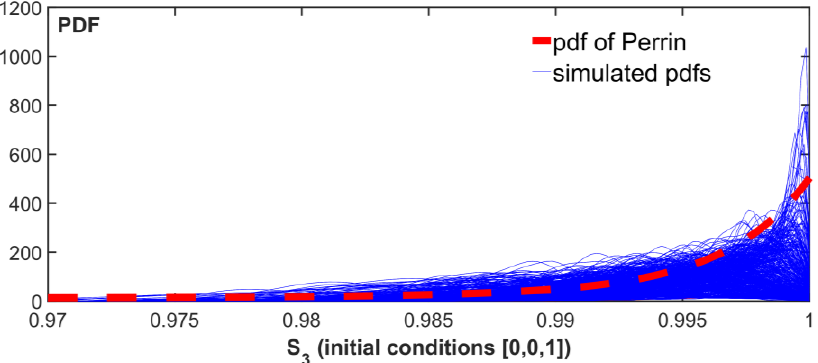
Figure 10. Perrin’s pdf and simulated pdfs for a circular SOP.